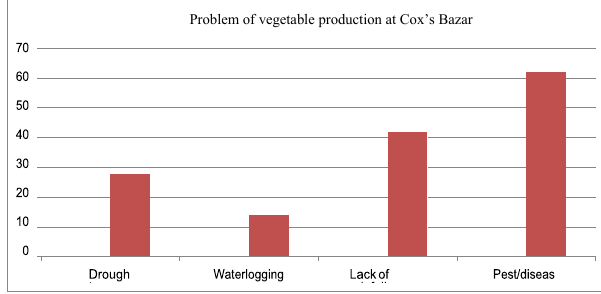
Figure 14: Farmers response on impacts of climate change on vegetable